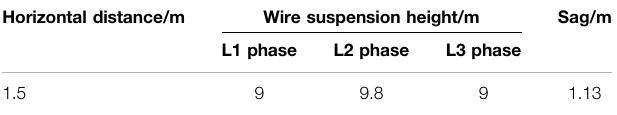
TABLE 2 | Wire position of 35 kV overhead line.